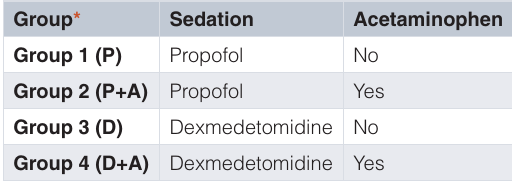
Table 1. Table 1 provides all different groups in the